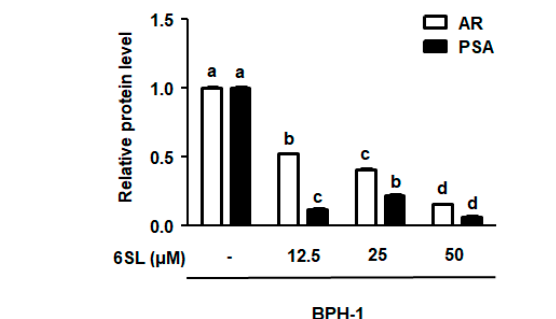
Figure 4. The inhibitory e ff ect of 6SL on BPH cell line (BPH-1) cells’ growth and androgen-relative protein expression. ( A ) BPH-1 cells were treated with various concentration of 6SL for 24 h to assay cell viability. ( B ) AR and PSA protein expression were determined by immunoblotting and relative protein level was analyzed. β -actin was used as an internal control gene. The densities of protein were calculated using ImageJ Software. Values of three separate experiments are represented as mean ± SD. Di ff erent letters indicate significant di ff erences, p < 0.05. DMSO; Dimethyl sulfoxide.